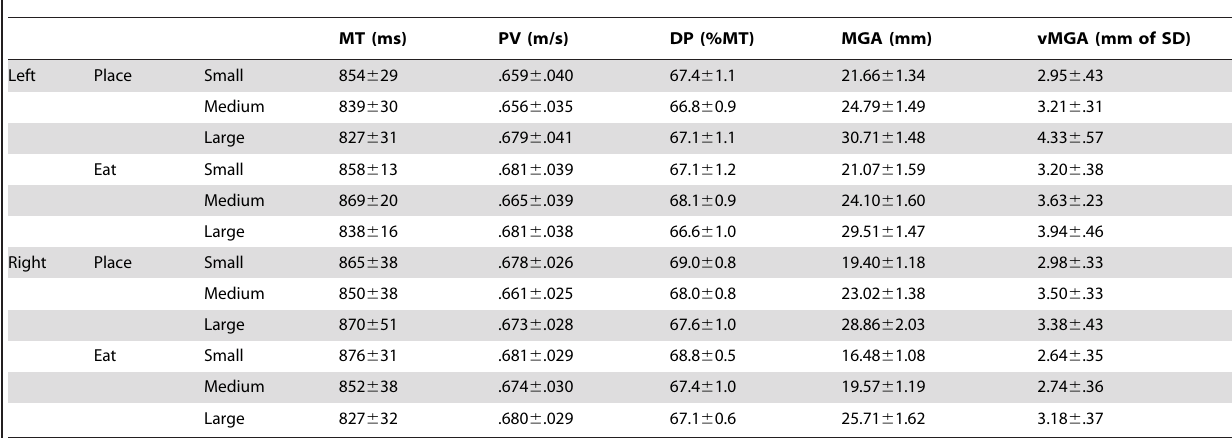
Table 1. Means and standard errors of reach and grasp kinematics.